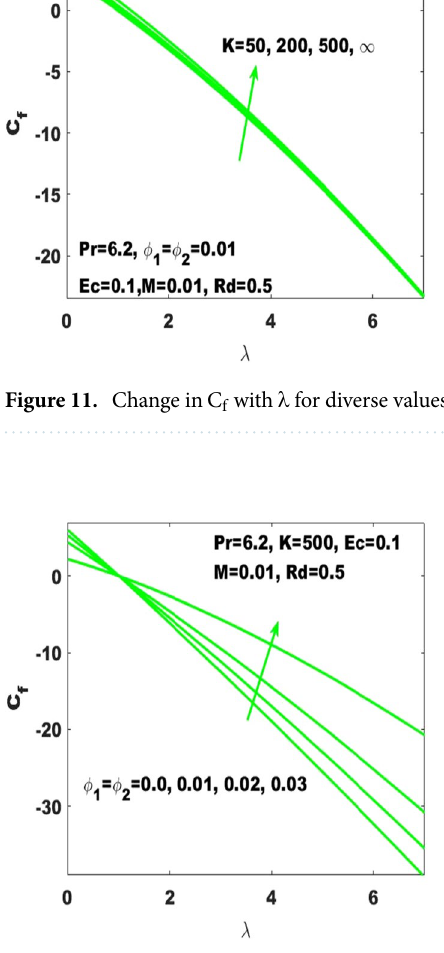
Figure 12. Change in C f with (cid:31) for diverse values of φ 1 and φ 2 .